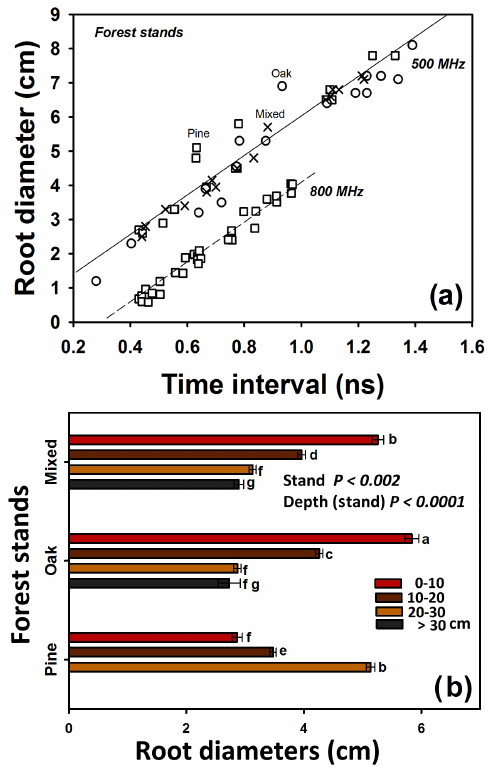
Figure 2. (a) Relationship between root diameter from different stands and time interval with zero crossing of detected roots, which were later used for calibration with both GPR systems: 500MHz shielded antenna ( n = 48), P <0.0001, and 800MHz shielded an- tenna ( n = 28), P <0.0001. (b) Average diameter of roots recorded with GPR for each of the three forest stand types at four depths. Dif- ferent letters next to the bars indicate statistical differences among treatment combinations at a probability value of P